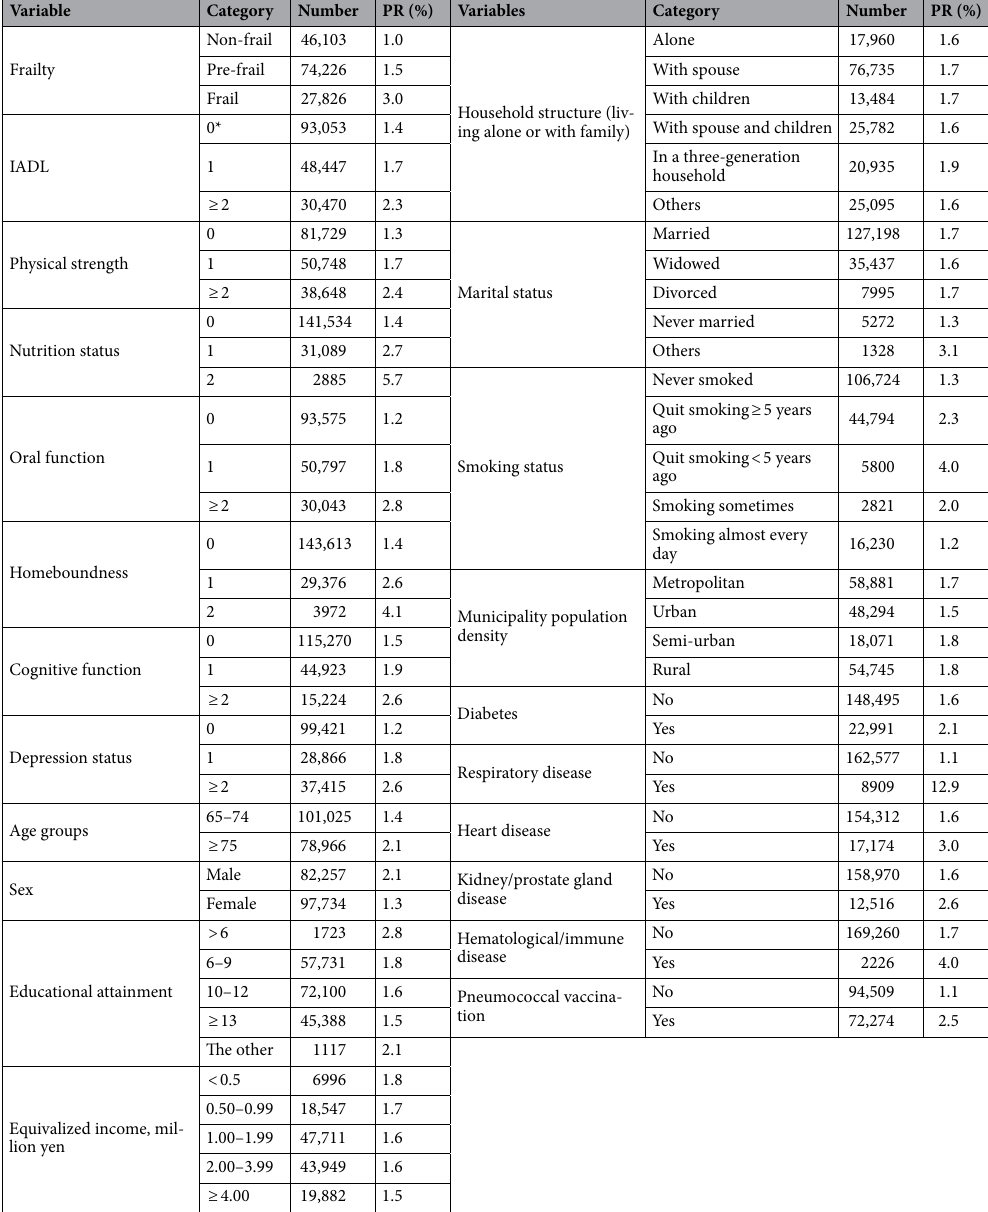
Table 1. Prevalence rates of pneumonia in comparison with the characteristics of older adults. *Numbers in IADL, physical strength, nutrition status, oral function, homebound, cognitive function, depressive mode are the numbers of the applicable KCL questions for the older adults. PR prevalence rate, IADL instrumental activity of daily living, KCL Kihon